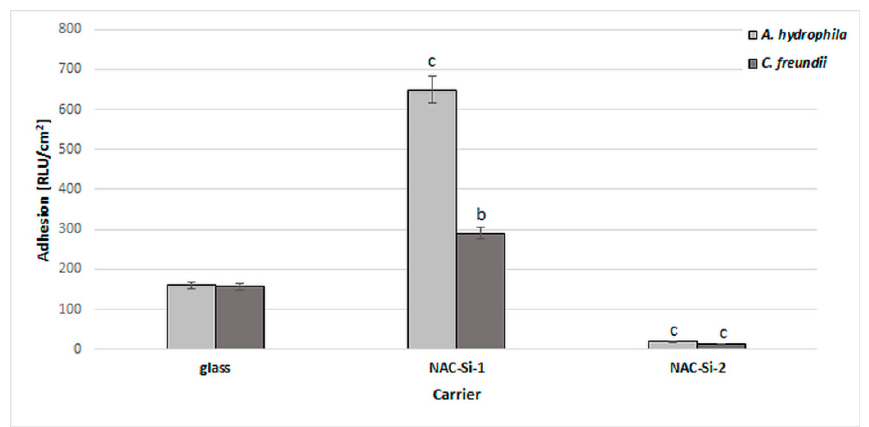
Figure 5. Effects of polymers NAC-Si-1 and NAC-Si-2 on biofilm formation by A. hydrophila and C. freundii after 6 days of incubation in M1 medium. The results are compared to those of the control glass carrier (glass without NAC polymers). Values show the mean ± standard deviation (SD, n = 3). Values with different letters are statistically different: b, 0.005 < p < 0.05; c, p < 0.005.